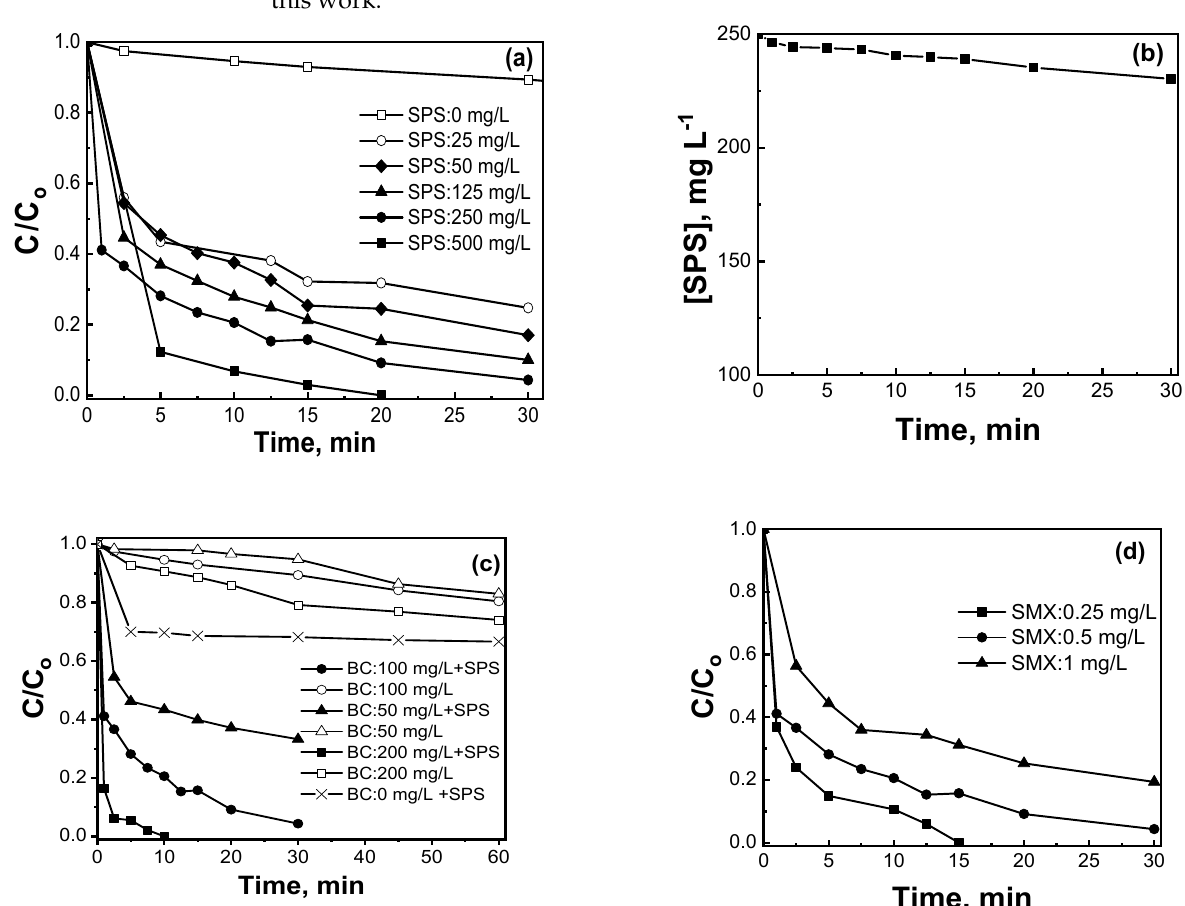
Figure 7. Removal of SMX in UPW and inherent pH as a function of ( a ) SPS concentration (0.5 mg L − 1 SMX and 100 mg L − 1 BC), ( b ) shows SPS consumption with 100 mg L − 1 BC, ( c ) BC concentration (0.5 mg L − 1 SMX with and without 250 mg L − 1 SPS), and ( d ) SMX concentration (100 mg L − 1 BC and 250 mg L − 1 SPS).